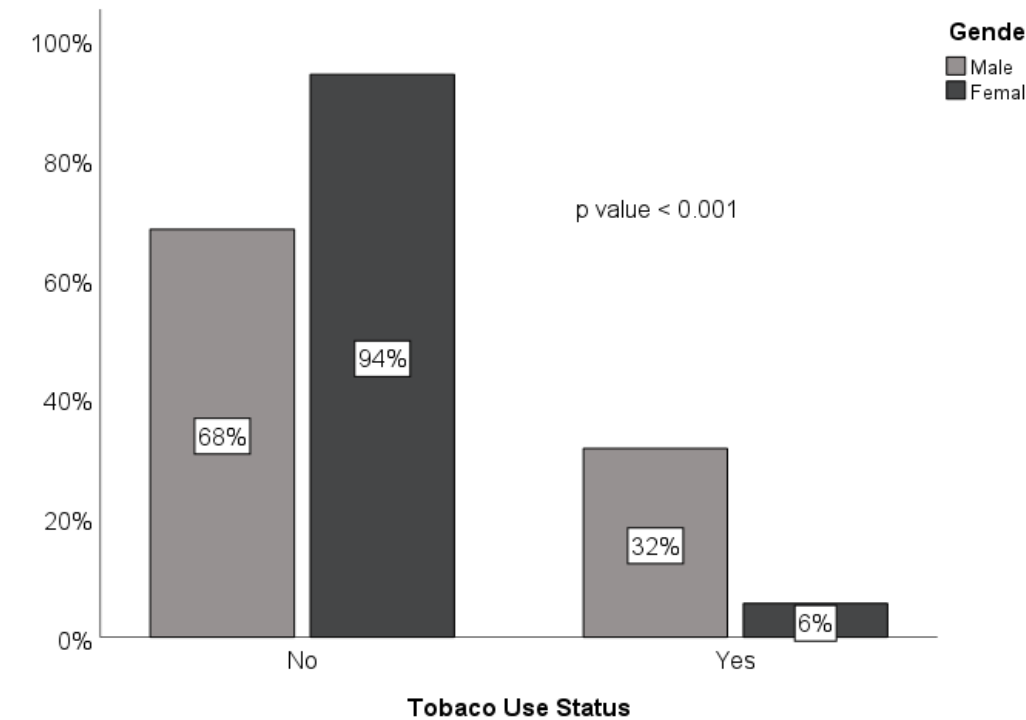
Figure 4. Distribution of tobacco use status by